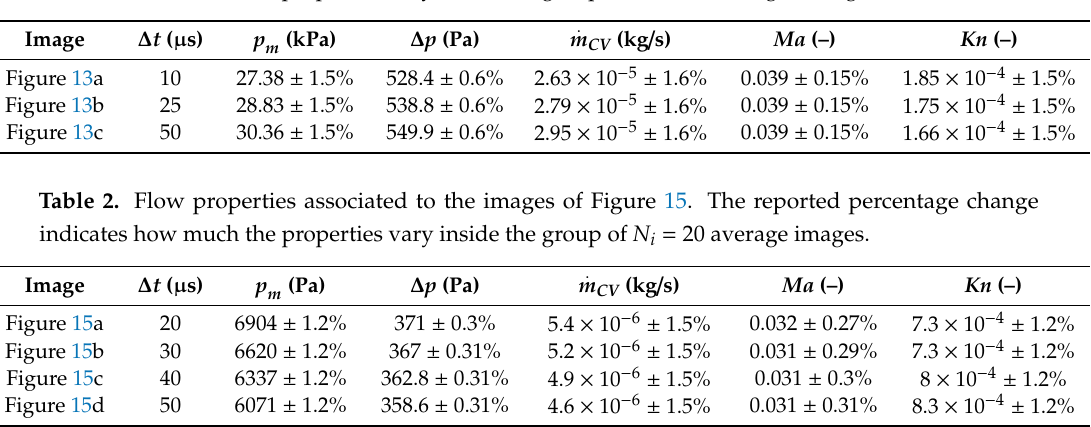
Table 1. Flow properties associated to the images of Figure 13. The reported percentage change indicates how much the properties vary inside the group of N i = 20 averaged images.